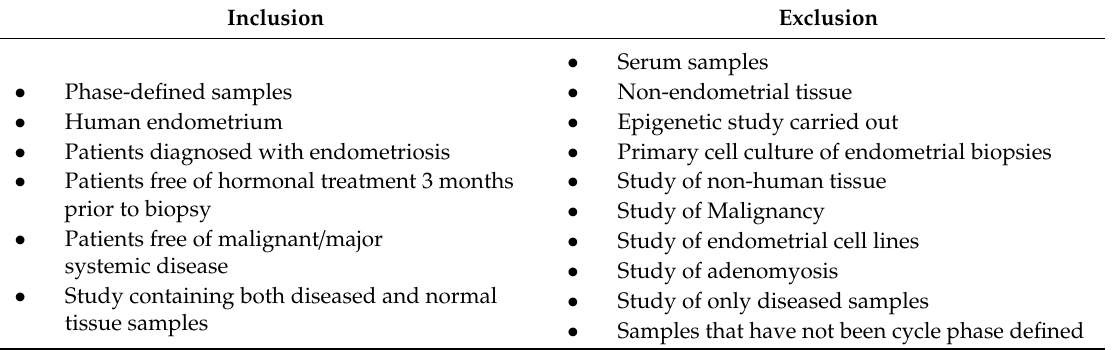
Table 3. Inclusion and exclusion criteria to select microarray datasets for in silico